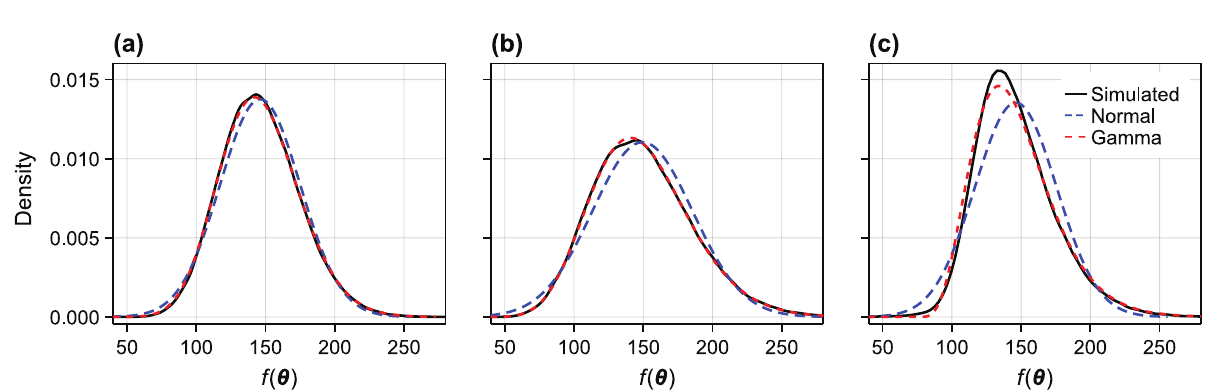
Fig 2. Accuracy of approximate transformation. We compare the accuracy of two approximate solutions to the non-linear transformation f ( θ ) (here, f ( θ ) is given by the solution to the logistic model and θ ¼ ½ l ; K ; r 0 � ⊺ , see Eq (24)). In (A) θ has a multivariate normal distribution with independent components; in (B) θ has a multivariate normal distribution with correlation between λ and K ; and, in (C) θ has independent, translated-gamma components such that the marginals have relatively strong skewnesses of ð o produced from 10 5 samples, the normal approximation (blue dashed), and the translated gamma approximation (red dashed). In the supporting material (Table A in S1 File) we provide a statistical comparison between the simulated and approximate distributions using the Kolmogorov-Smirnov